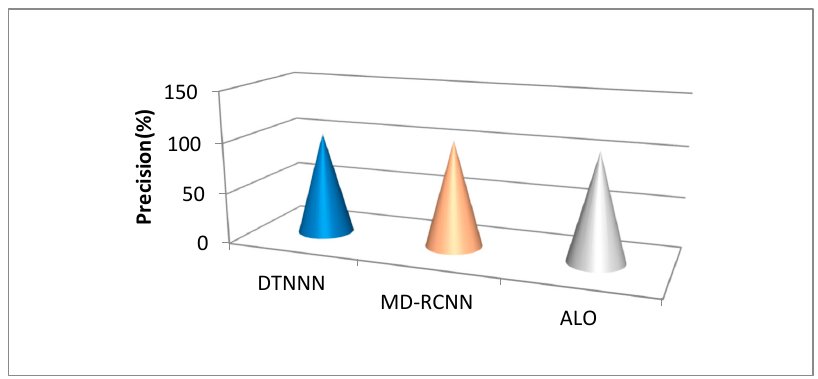
Table 2. Accuracy and precision analysis.